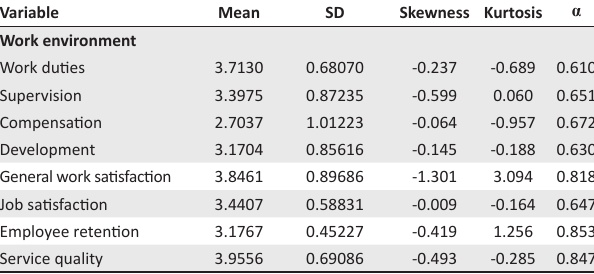
TABLE 1: Descriptive statistics of the